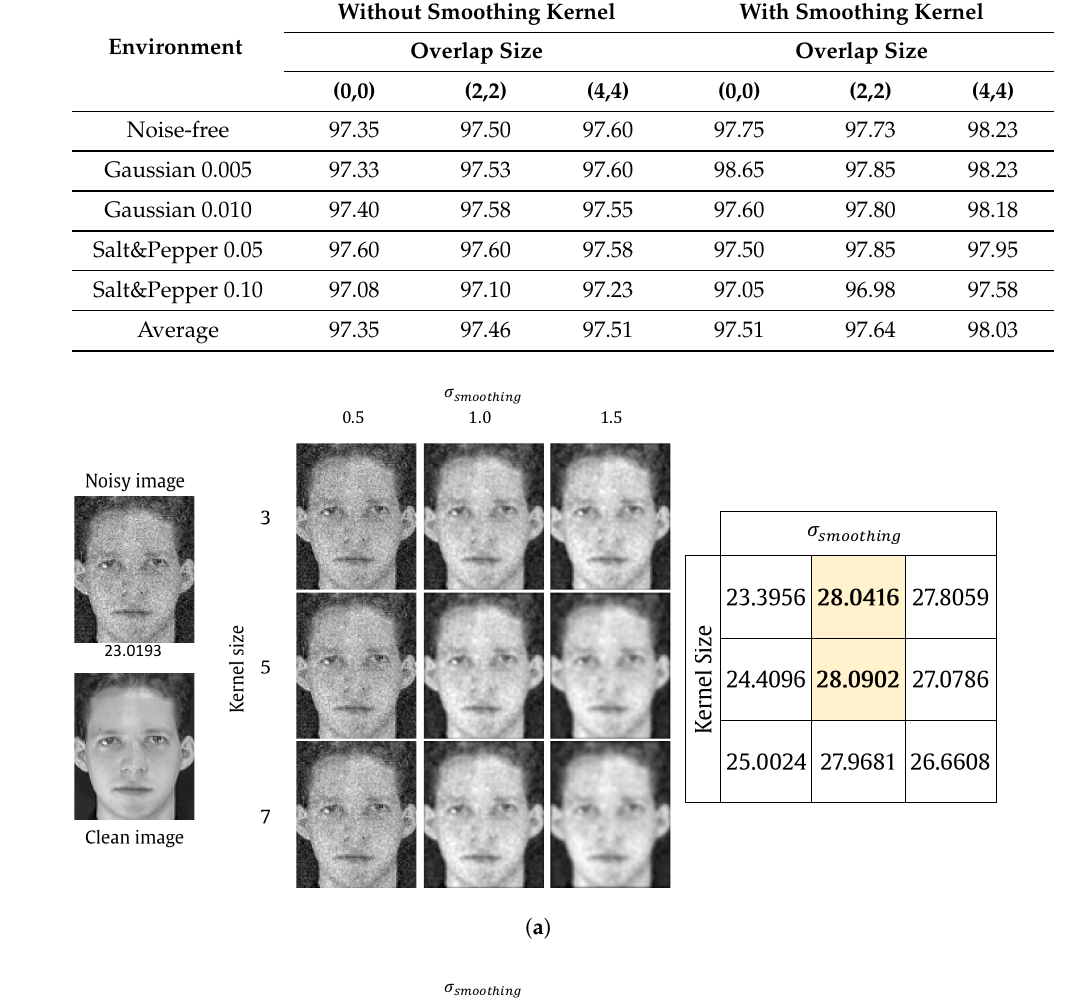
Table 2. ORL recognition rates (%) using the proposed approach with/without smoothing kernel